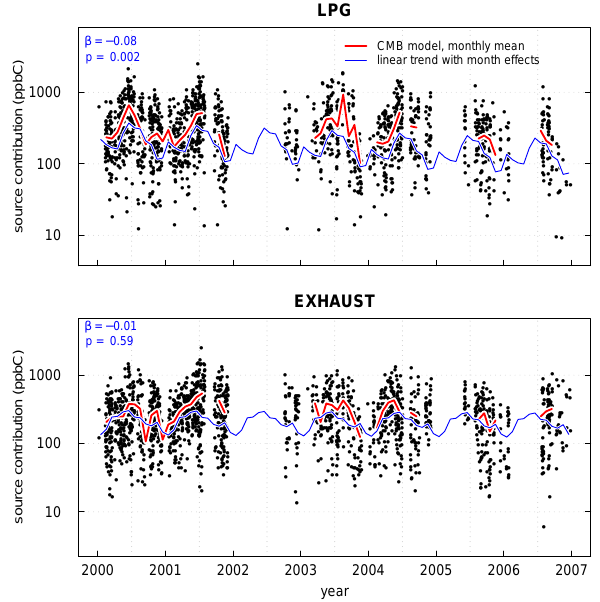
Fig. 5. Time series, monthly means and linear trend with month ef- fects of the absolute LPG and vehicle exhaust source contributions.